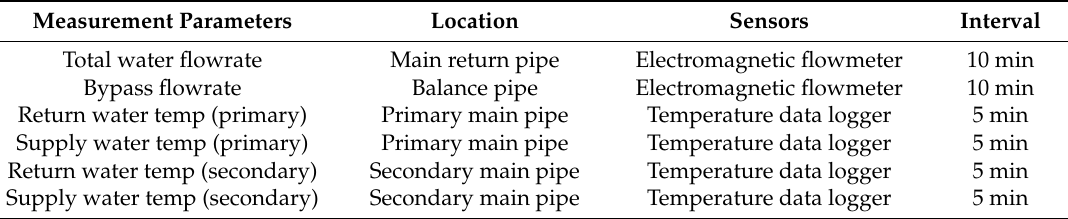
Table 1. Monitored operational data from BMS for case